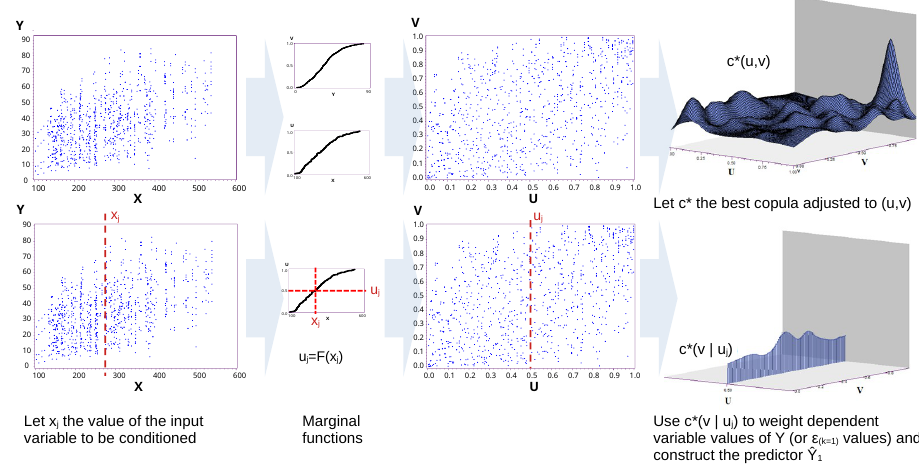
Figure 2. Construction of an ADABOC